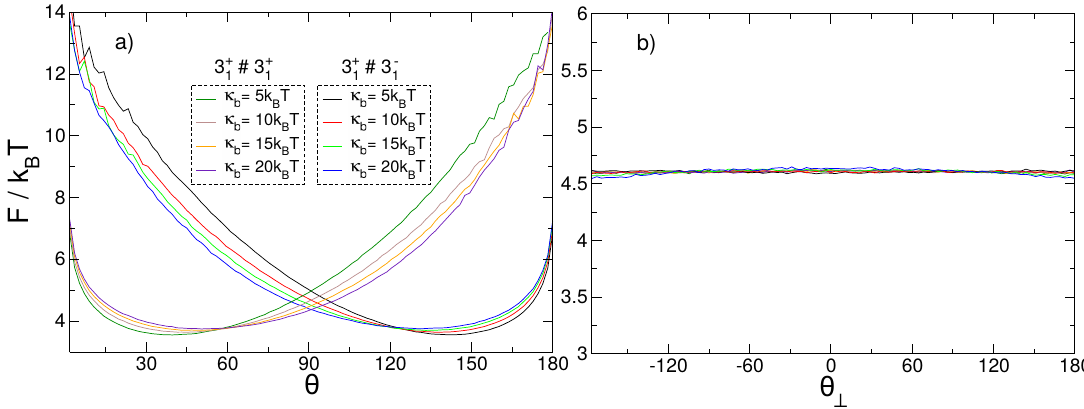
Figure 8. Free energy of two separated trefoil knots projected along ( a ) θ and ( b ) θ ⊥ for four different values of polymer bending